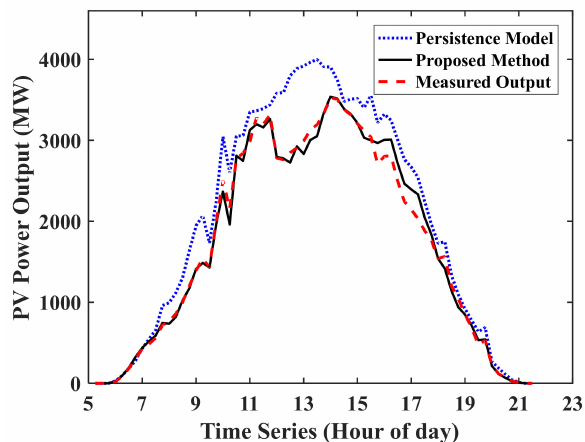
Figure 12. Regional output predictions compared with proposed method and persistence